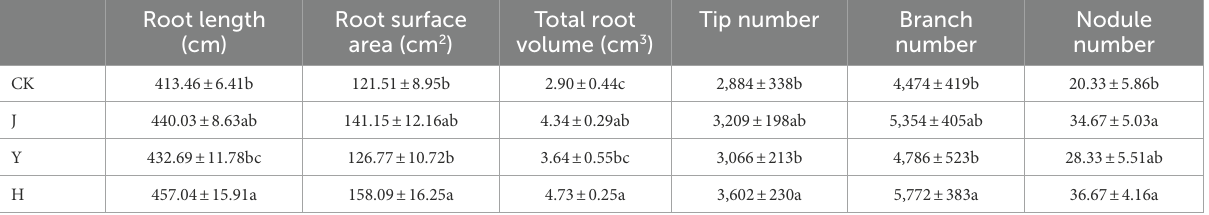
TABLE 4 Comparison of root indexes of soybean after treatment with various bacterial